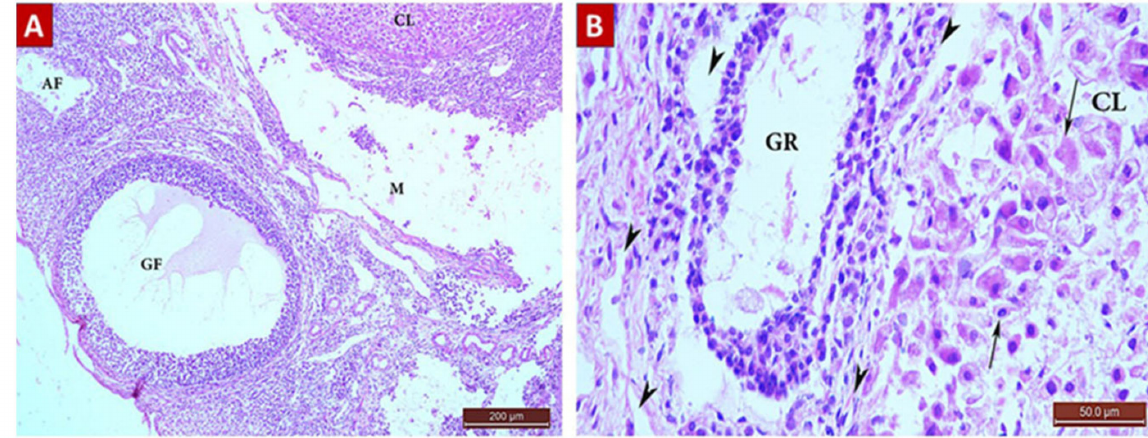
Figure 5. H&E Photomicrograph from The POI (G II) group showing extensive ovarian damage. ( A ) Ovarian section from G II rat at x100 magnification showing a damaged Graafian follicle (GF) with no cumulus oophorus and loss of other follicle stages with multiple atretic follicles (AF). The medulla (M) and cortical tissue showed destruction with edema. ( B ) Ovarian section from G II rat at x400 magnification showing shrinkage of granulosa cells with nuclear pyknosis. The wall of the GF was separated and destructed with edema (arrow heads) with loss of demarcation between its layers. The corpus luteum (CL) shows necrosis, shrinkage, and pyknosis or loss of the cells nuclei (arrows), loss of cells in other areas, and destruction of its wall.